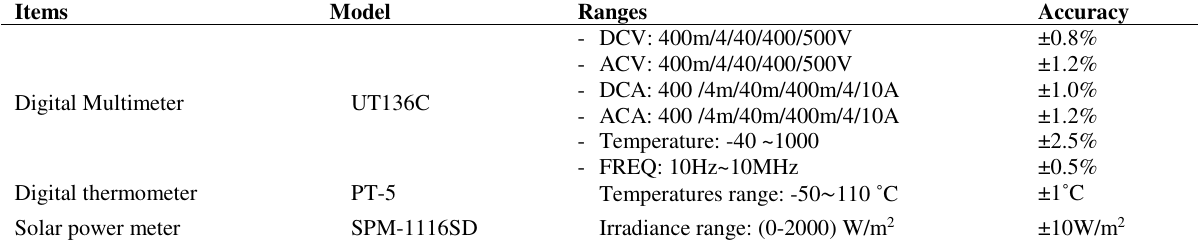
Specifications and accuracy of measurement